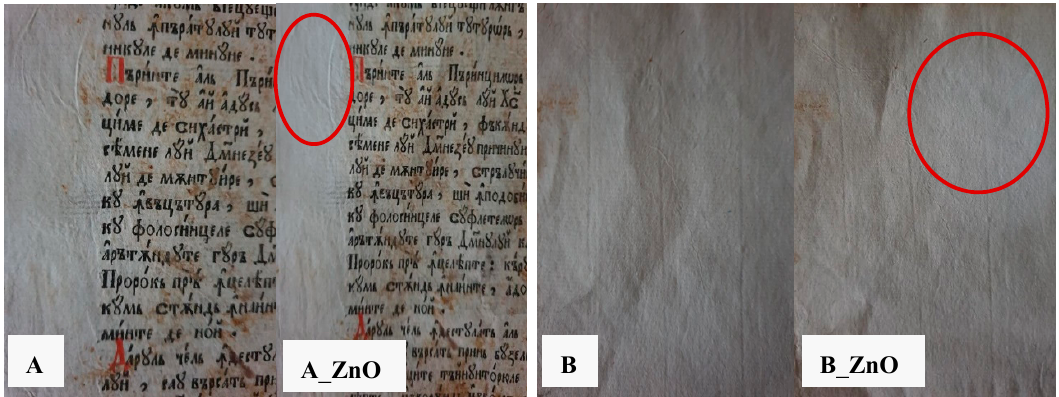
Figure 11. The original paper A and B and treated paper A_ZnO and B_ZnO.